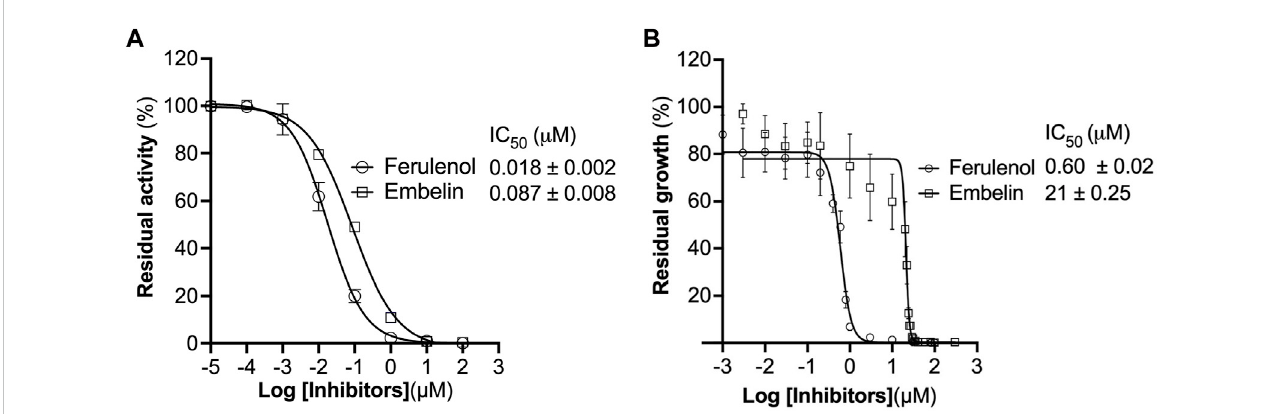
FIGURE 3 EffectofferulenolandembelinonCjMQOand C.jejuni growth. (A) Inhibitionofpuri fi edCjMQObyferulenolandembelin.Theresidualenzymaticactivity was measured in a mixture containing 50 mM MOPS pH 7.0, 100 μ M UQ1, 1 mM KCN, 0.2 μ g/mL of puri fi ed CjMQO, and varying concentrations of embelin andferulenol.Thereactionwasstartedbytheadditionof10 mMmalate.Valuesrepresenttheaverageoftriplicatemeasurements. (B) Invitro effectofembelin and ferulenol on the growth of C. jejuni ATCC29428. Campylobacter jejuni was cultured in Muller Hinton broth for 24 h with a starting OD 600 of 0.01 in the presence of varying concentrations of ferulenol and embelin. Kanamycin and cipro fl oxacin (50 μ g/mL each) were used as the positive control (100% inhibition). The resazurin assay was used to determine the residual growth on 96-well plates. Values represent the average of triplicate